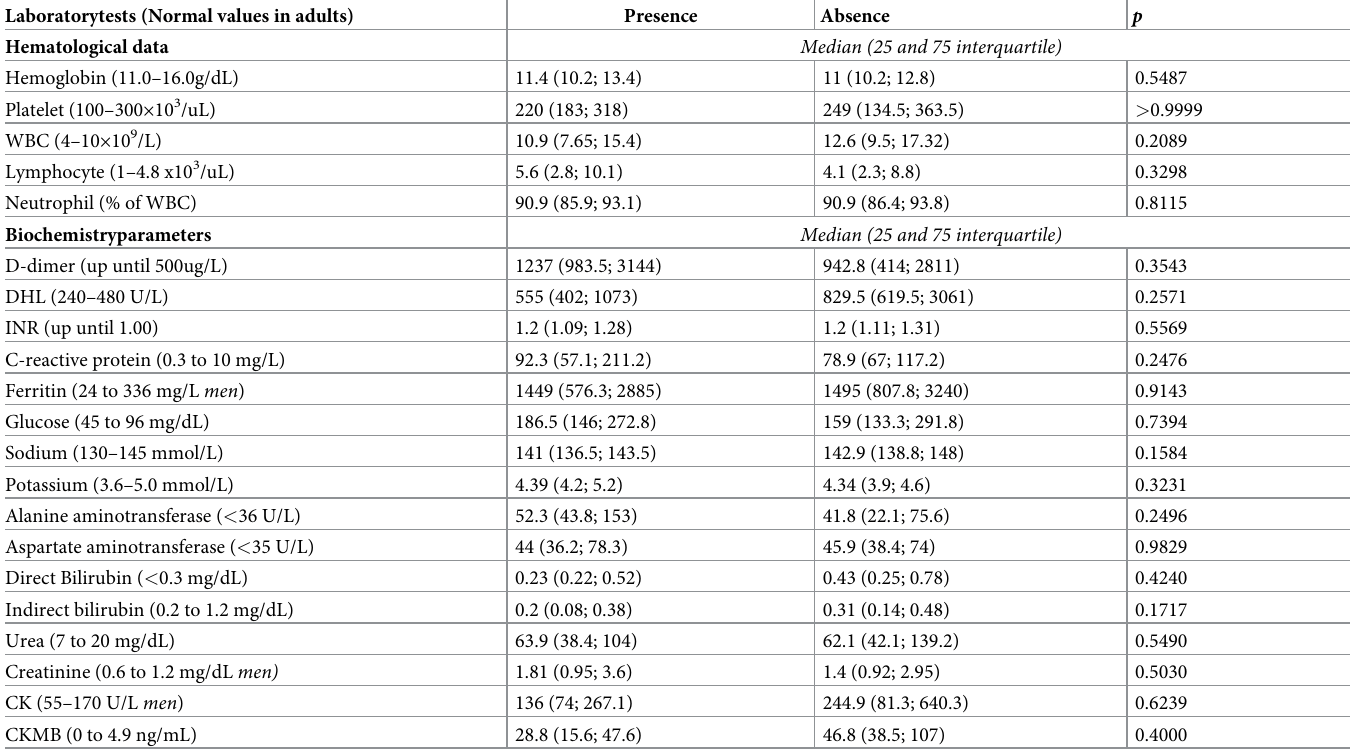
Table 3. Laboratory tests and analysis of data between study